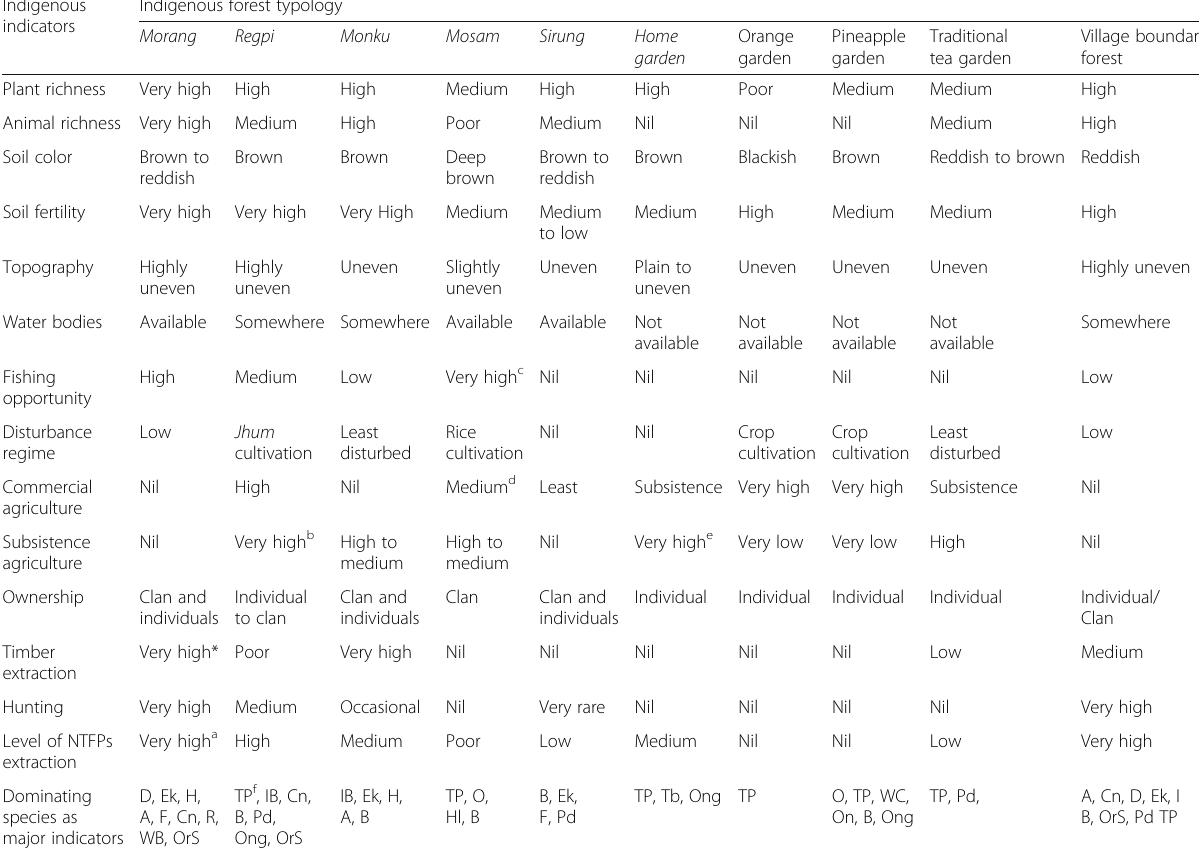
Table 1 Indigenous knowledge of classifying local forest by Adi tribe Indigenous